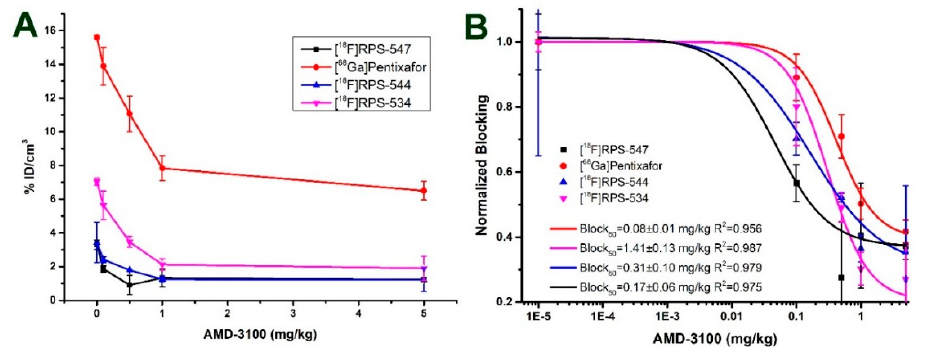
Figure 6. The effect of co-injection of 0.1, 0.5, 1, or 5 mg/kg of AMD-3100 on uptake of [ 18 F]RPS-534, [ 18 F]RPS-544, [ 18 F]RPS-547, and [ 68 Ga]Pentixafor in PC3-CXCR4 xenograft tumors. ( A ) Absolute tumor uptake as a function of the mass of AMD-3100. Uptake was quantified from µPET/CT images; ( B ) block 50 values determined by binding curves fitted to the in vivo data. For fitting, negligible blocking was assumed for all compounds at 1 µg/kg AMD-3100. Based on the molar activity of the radioligands, the average amount of non-radioactive compound in the radiopharmaceutical injection was estimated to be 10 ng/kg.